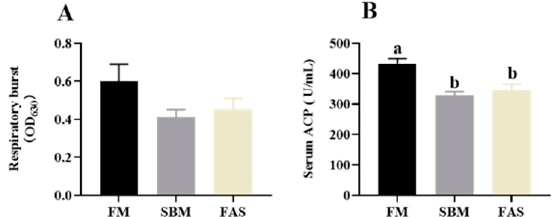
Figure 3. Immune responses of Japanese seabass fed diets using soybean meal as fishmeal alterna-